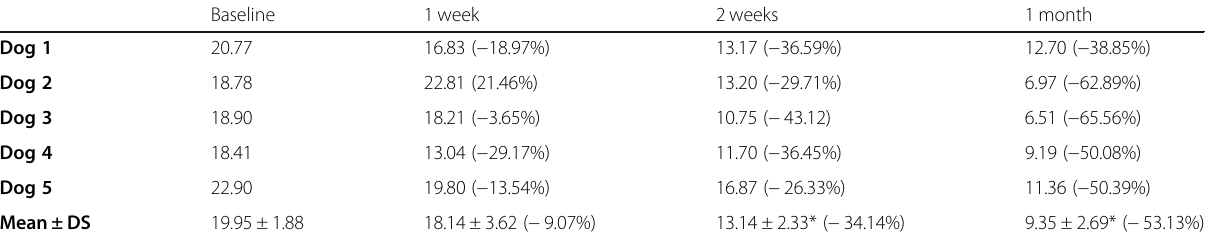
Table 1 MRI measurements: prostate volume (mL) at different times of follow-up Baseline